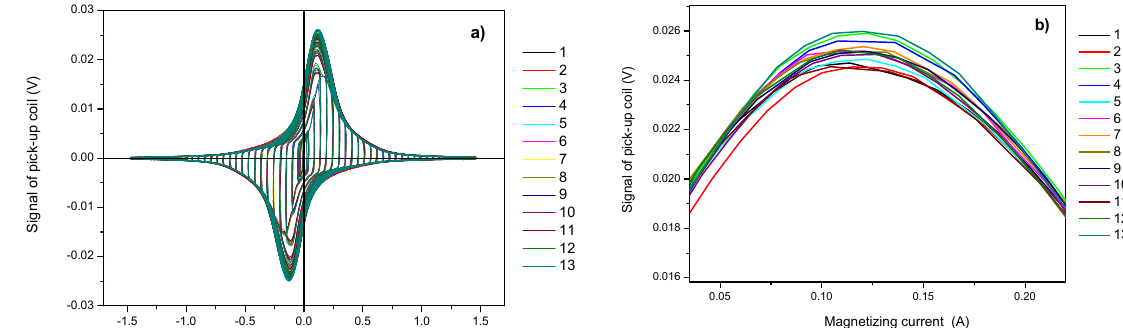
Figure 4. The measured permeability loops of the investigated, not-irradiated samples. ( a ) Full loops, ( b ) magnified parts of the loops.